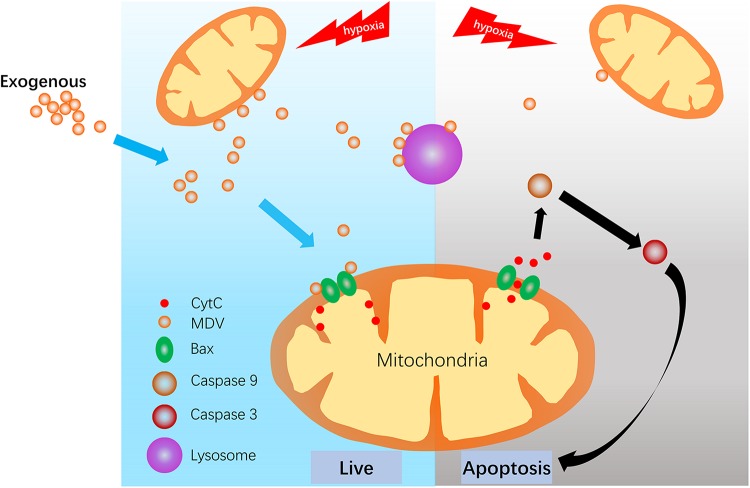
Schematic depiction of the potential protective effect of MDVs during hypoxic stress.